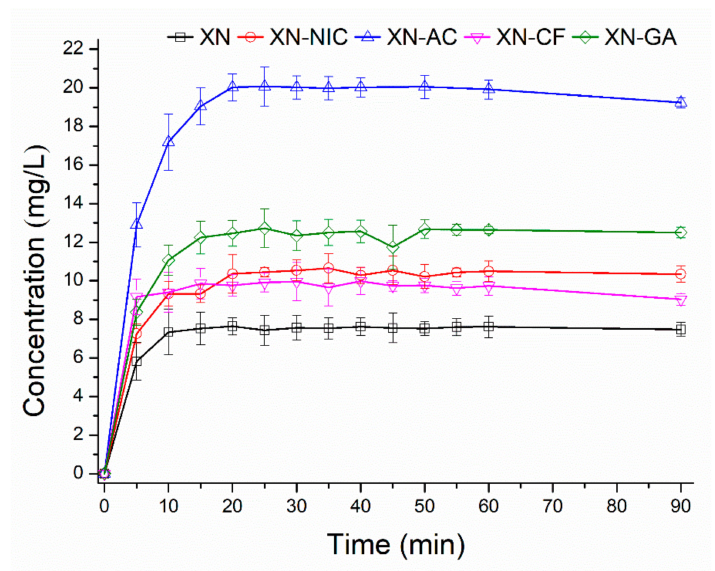
Figure 10. Solubility profiles of XN and its cocrystals (XN − CF, XN − NIC, XN − GA, and XN − AC) in a 50:50 ( v / v ) ethanol–water solution at 27 ◦ C.